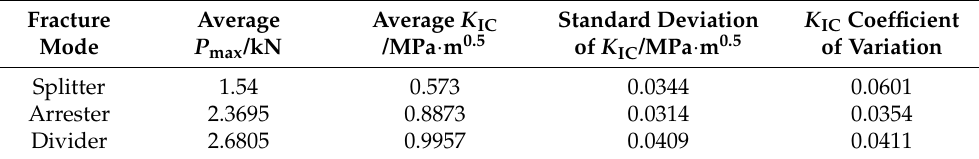
Table 5. Statistics of NSCB test results for three kinds of shale